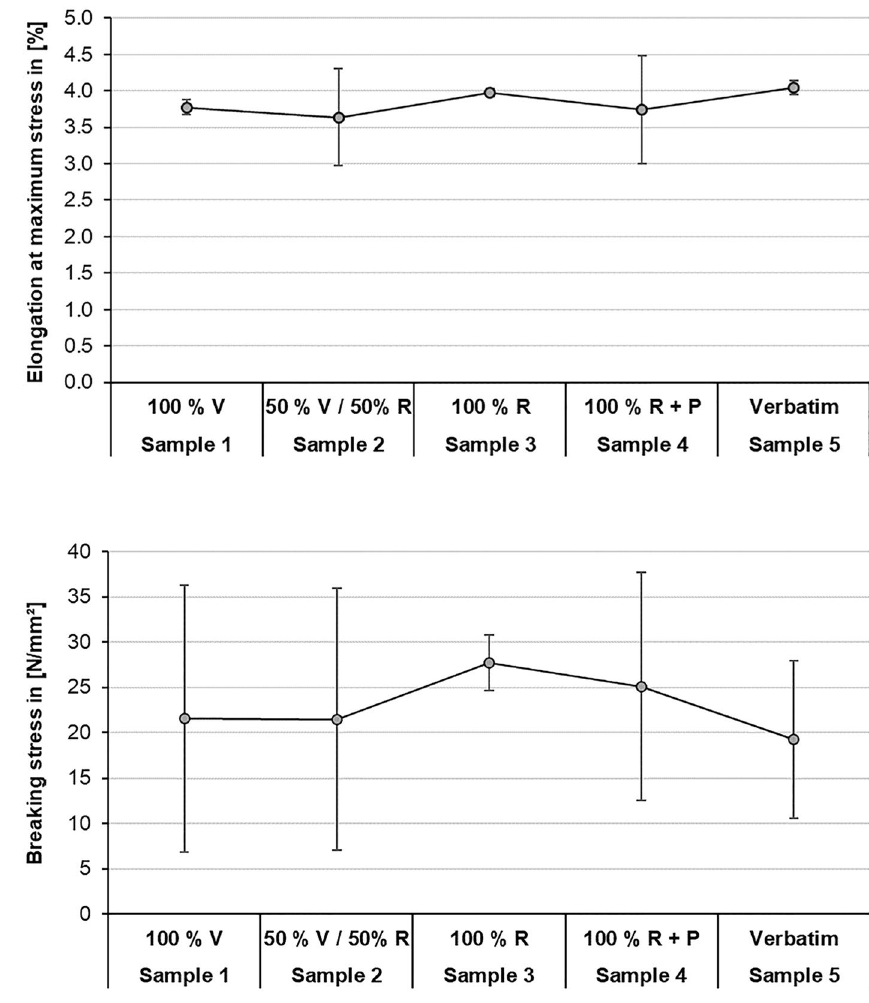
Fig. 12 Overview of elonga- tion at maximum tensile strength for the different fila- ment samples